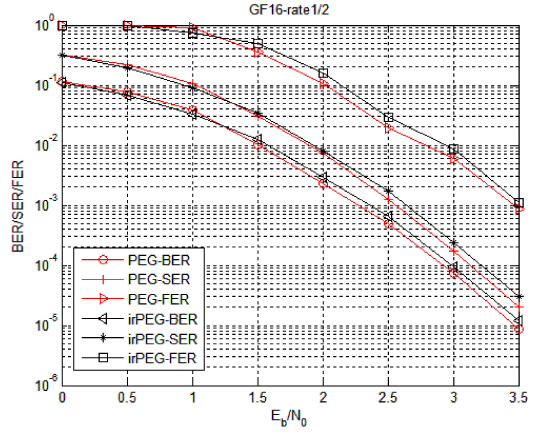
Figure 5. The error correction performance of improved progressive edge growth (irPEG) algorithm in Code1.